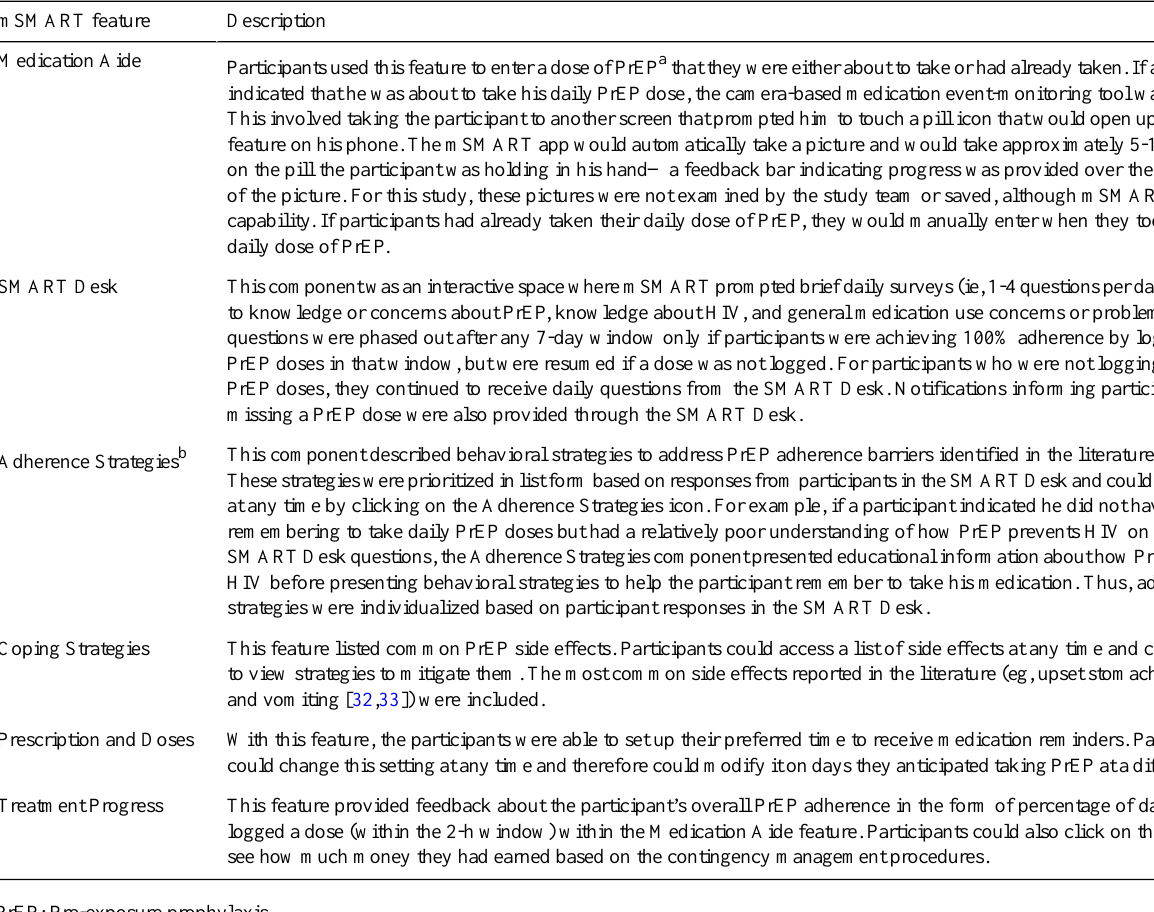
Table 1. Description of mSMART